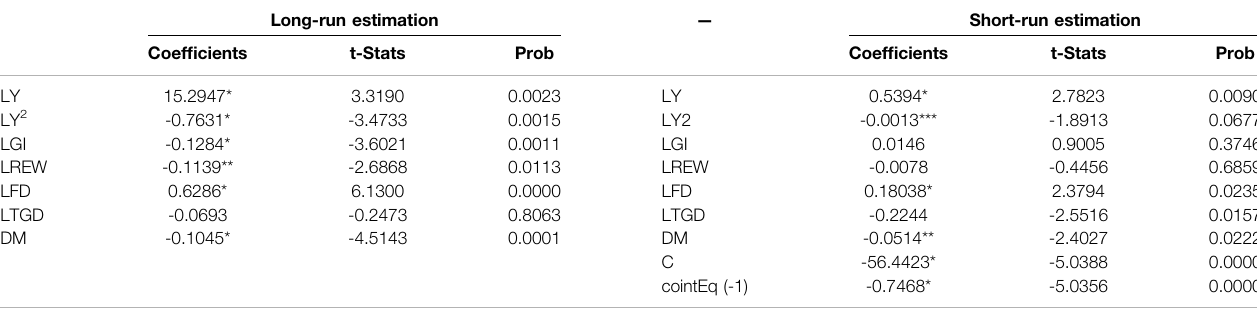
TABLE 6 | Robustness analysis (long & short-run results) model 2 Long-run estimation — Short-run estimation